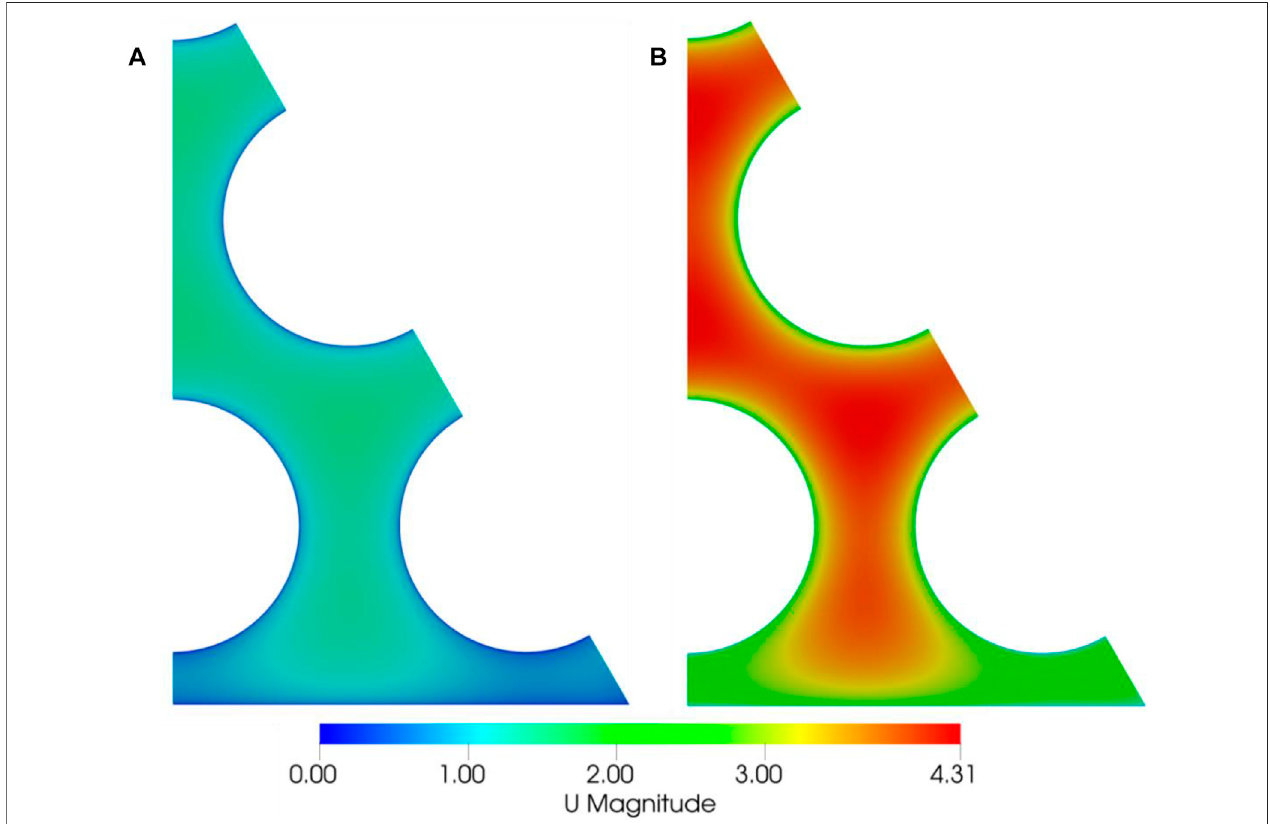
FIGURE 6 | Pro fi les of velocity magnitude on a computational domain. (A) Pe bun (cid:2) 500 and (B) Pe bun (cid:2) 1500 .